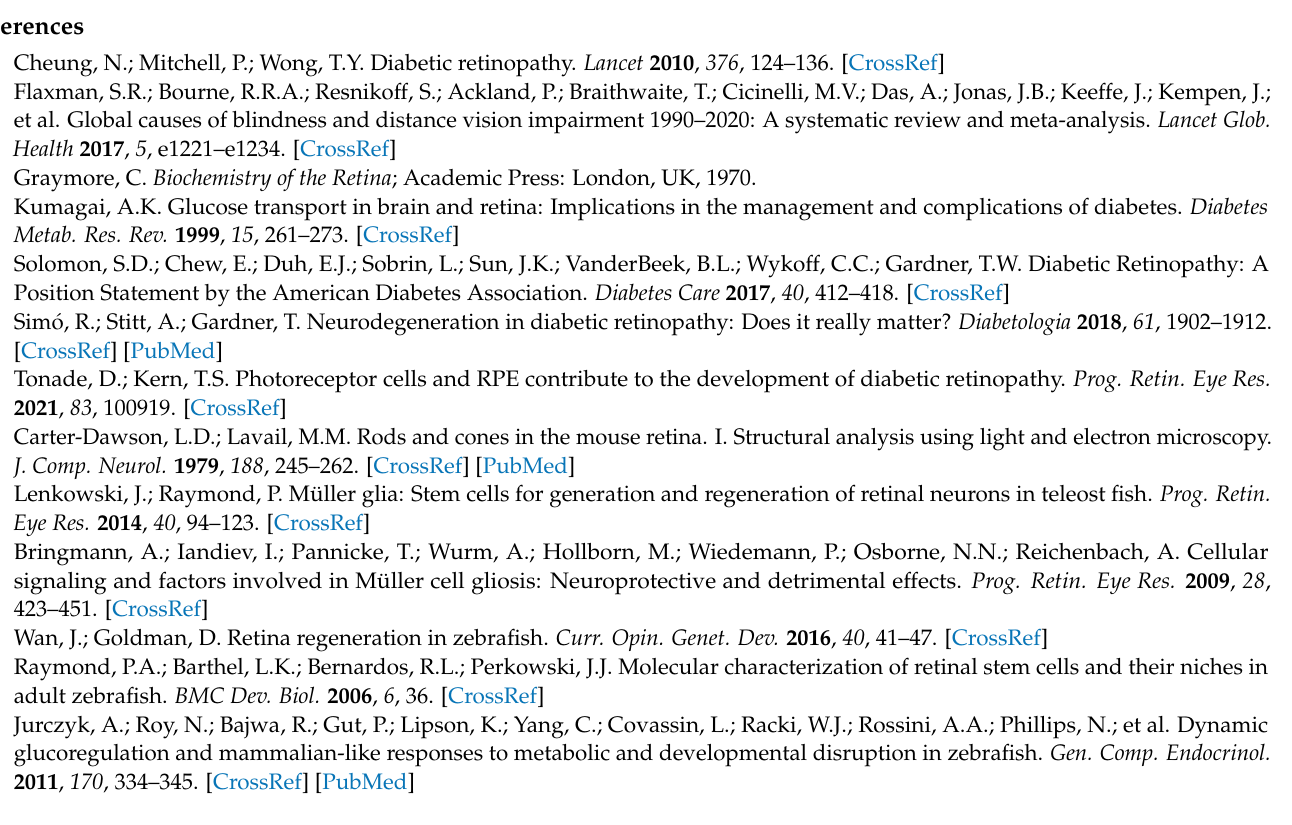
Figure S2: Reduced cells in the ONL of pdx1 mutants, Figure S3: Variable proliferation phenotypes in pdx1 − / − mutant neural retina, Figure S4: GFAP staining is not changed by chronic hyperglycemia, Figure S5: Cell populations labeled by pax6b:dsRed and